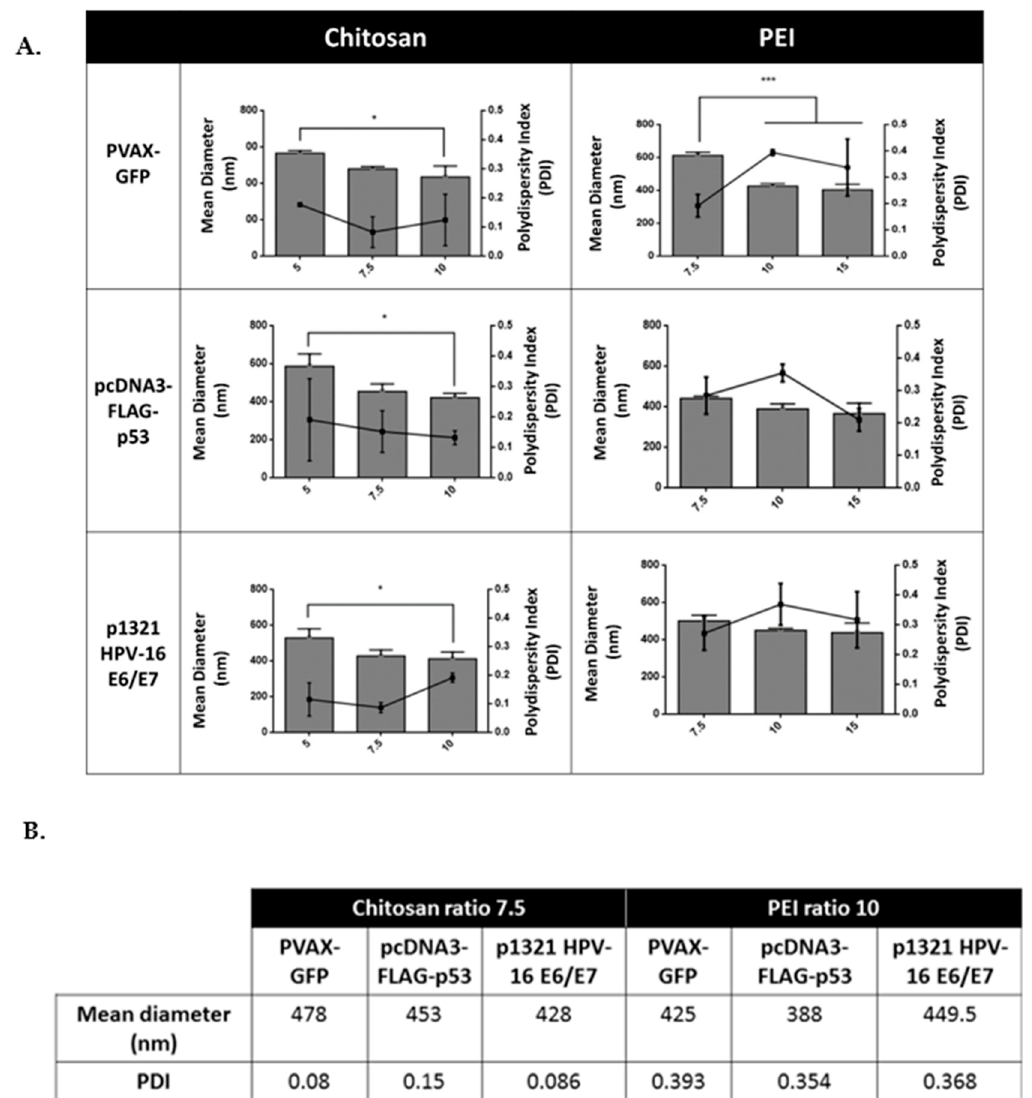
Figure 3. ( A ) Mean diameter (nm) and Polydispersity (PDI) values of the selected nanocomplexes; ( B ) Values obtained for the specific ratios chosen for the biological experiments. The asterisks indicate a statistically significant difference in the mean diameter between the polyplexes produced with the different polymer ratio studied. Data are presented as mean ± S.D., n = 3 (* p < 0.05 and *** p < 0.001).